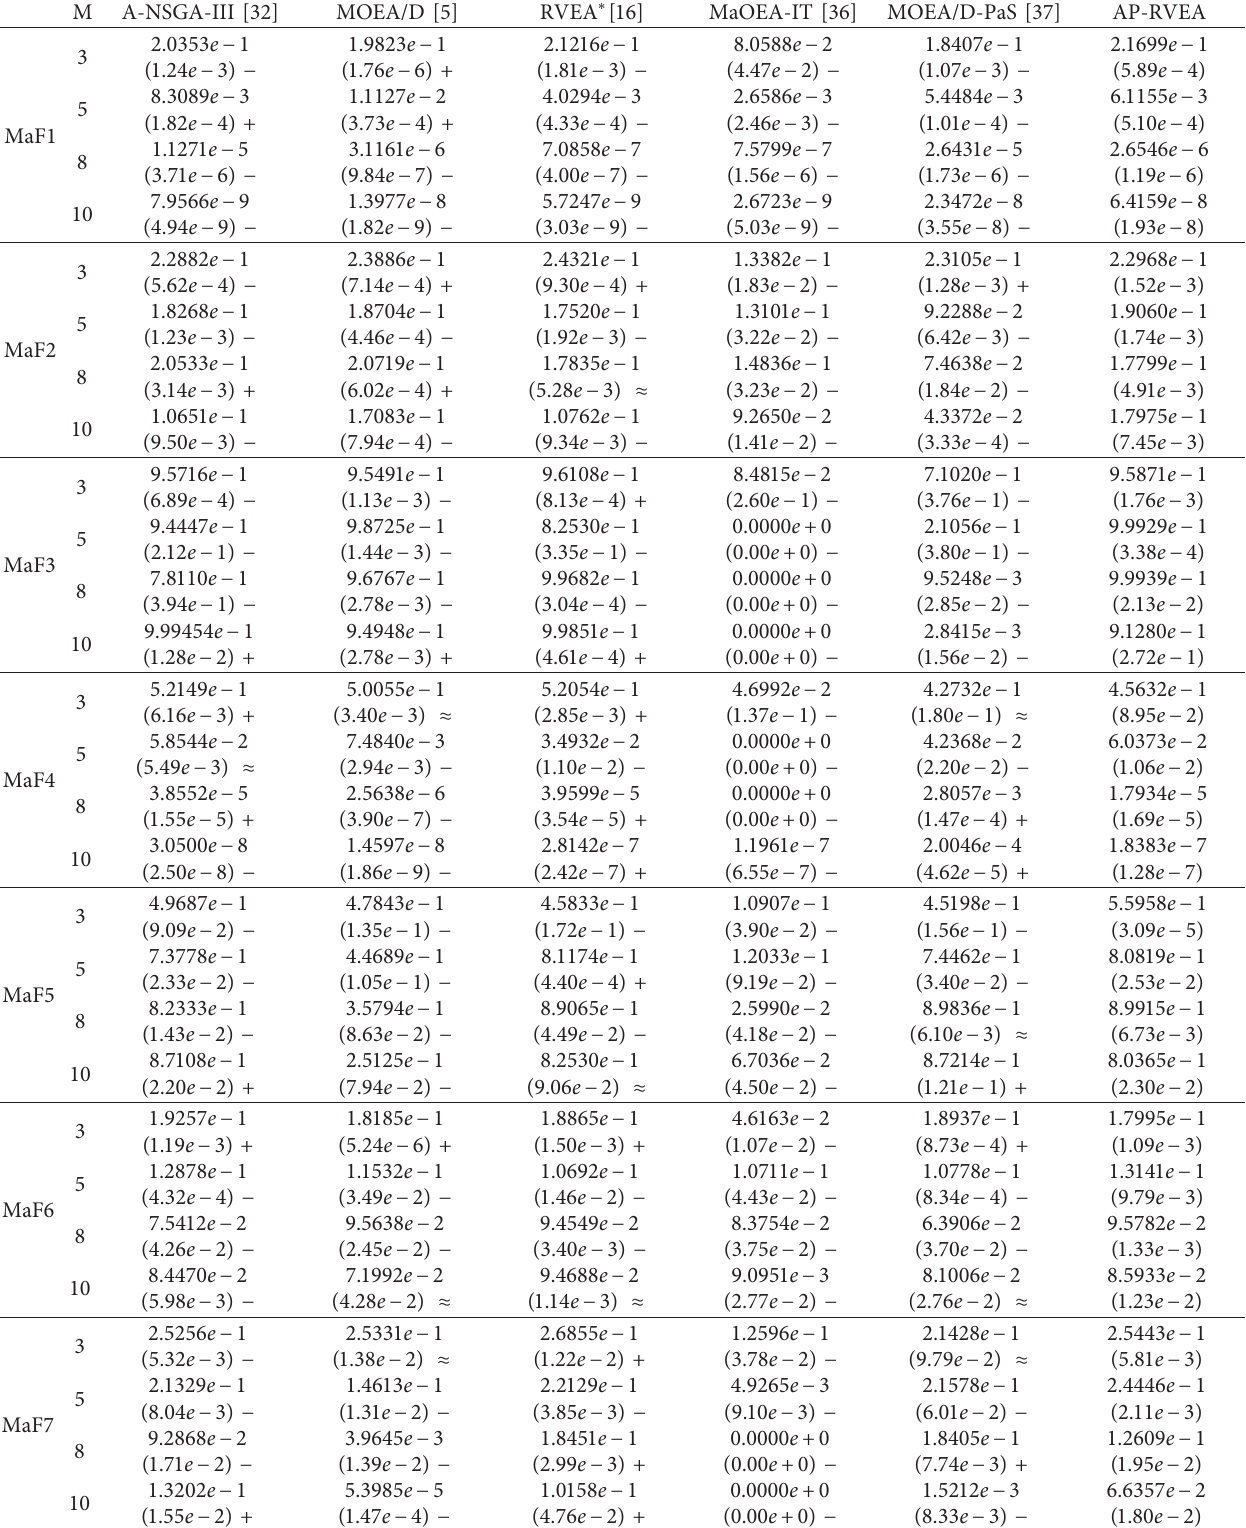
Table 1: HV results of the 6 algorithms on benchmarks